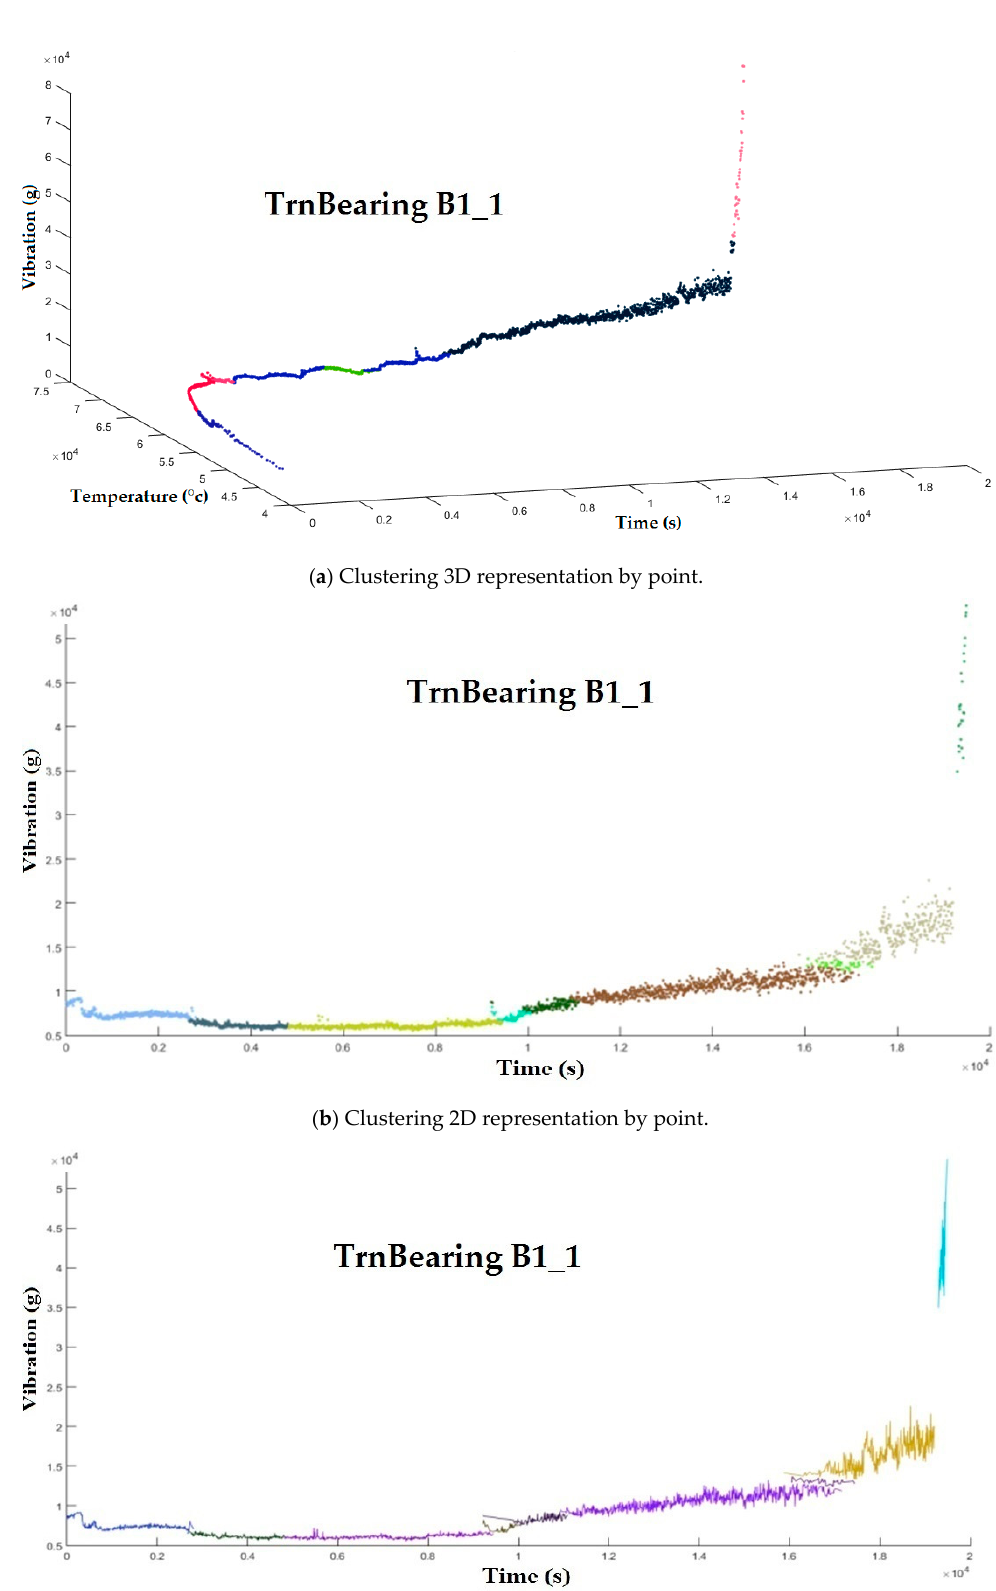
Figure 18. VNS-clustering result for PRONOSTIA dataset B1_1.